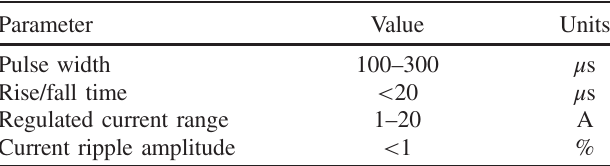
TABLE II. Arc Modulator Specifications.